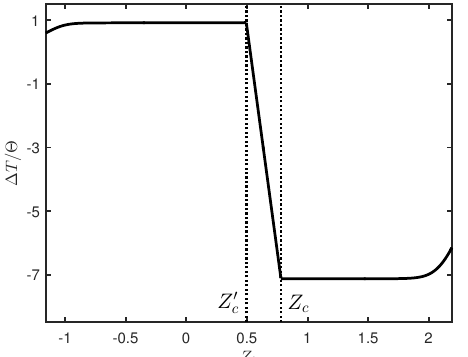
Figure 8. Change in the inter-seismic time before the next event on the 1992 Landers, California, fault, as a result of the stress per- turbation due to the 1999 Hector Mine, California, earthquake. On the horizontal axis, the variable Z 1 describing the initial state of the 1992 event. The kinds of seismic event predicted by the model, cor- responding to different intervals of Z 1 , are listed in Table 3. The val- ues Z 1 = Z c and Z 1 = Z (cid:48) c correspond to the largest possible earth- quakes before and after the stress perturbation,